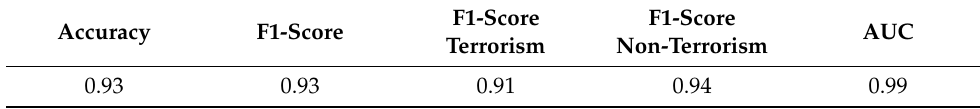
Table 1. Performance of the terrorism-related classification model.